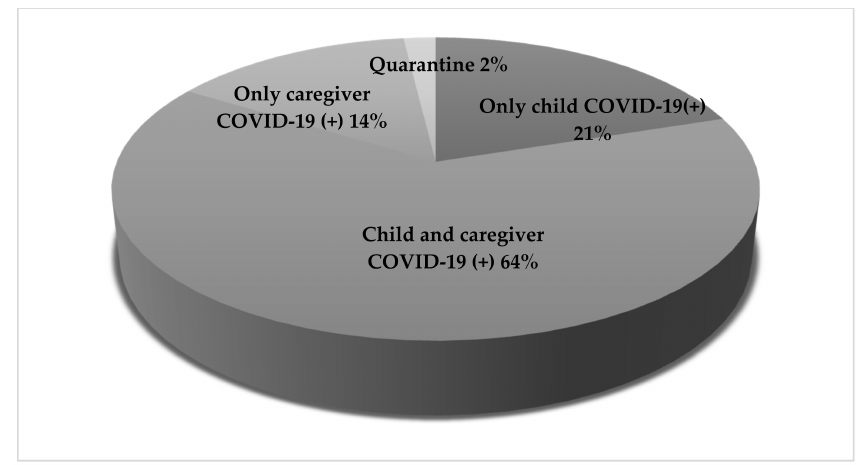
Figure 1. The COVID-19 status in children who remained in the COVID-19